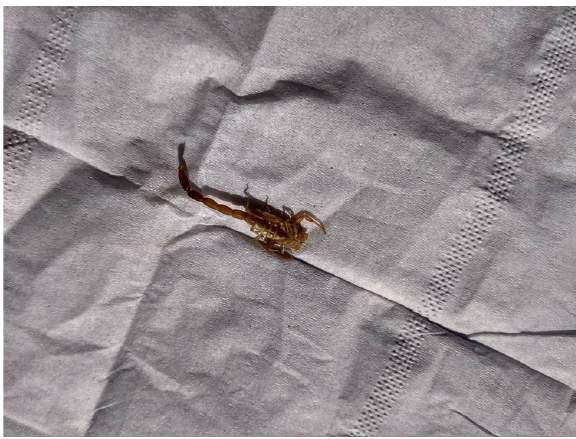
Figure 2. Ventral surface of Compsobuthus